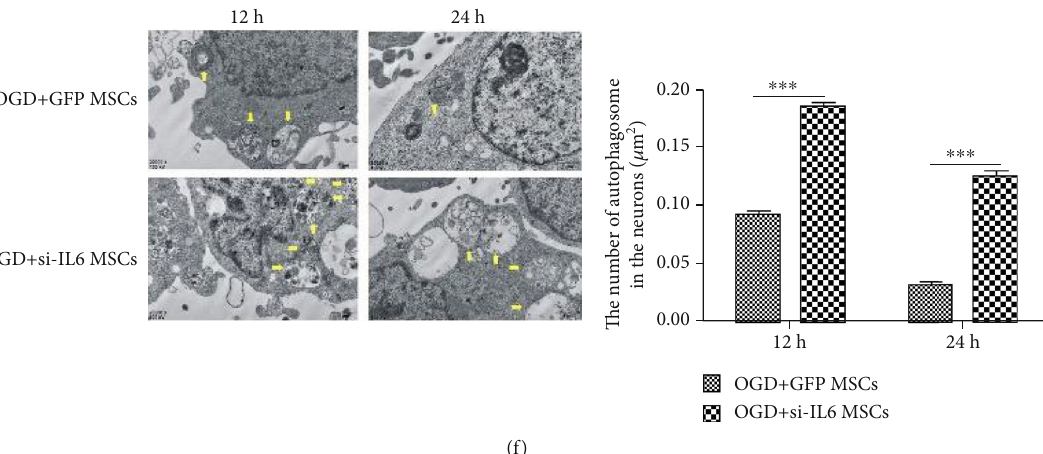
Figure 4: Separate siIL-6 MSC coculture increased Beclin 1 and LC3 II protein expression levels and reduced IL-6 and p62 protein expression levels, as well as increased the number of autophagosomes in hippocampal neurons injured by OGD, following damage for 12h and 24 h. (a) Representative western blots of IL-6, Beclin 1, LC3 II, and p62 protein expression levels in the OGD-injured neurons cocultured with siIL-6 MSCs or GFP MSCs for 12h and 24 h. (b – e) Quanti fi cation analysis of the neuron protein expression levels normalized to β -actin for the two groups. (f) Observation of autophagosomes in neurons from the two groups according to transmission electron microscopy (yellow arrows); quanti fi cation analysis of the autophagosome numbers in neurons from the two groups. Scale bars = 2 μ m , ( n = 6 , ∗∗∗ P < 0 : 001